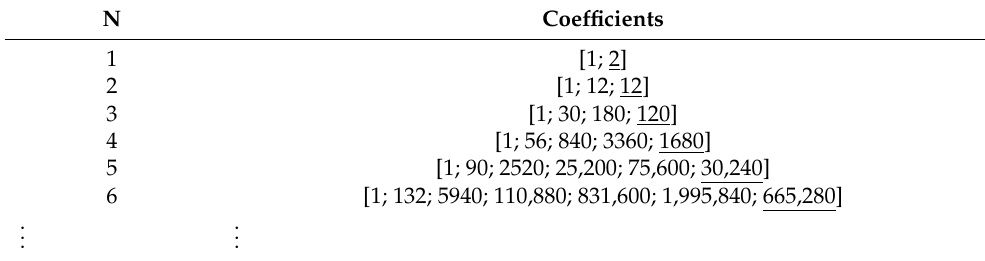
Table 2. Coefficients generated by polynomials whose spatial variables have even exponents ( q = 1 )